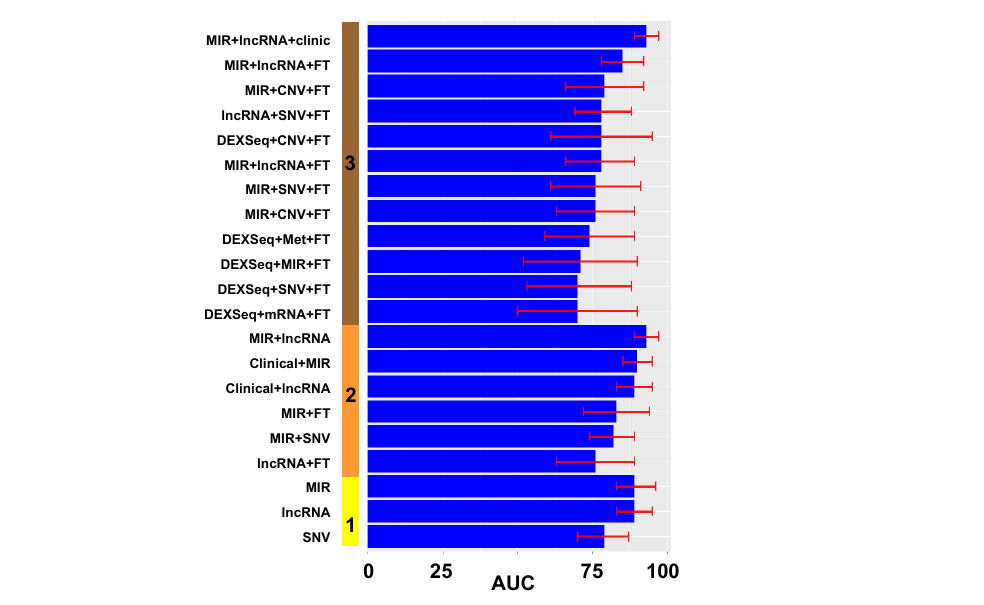
Figure 5. Performance of prediction models with selected variables from the best initial models in optimal cytoreduction. The solid vertical bar represents the number of types of data: 1 (yellow): only one variable was included in the model; 2 (orange): a combination of 2 types of variables; 3 types of variables: solid vertical line with 3 labels (maroon). Different performances are displayed in ascend ‐ ing order. The x axis is AUC as a percentage (0–100%). The red error mark displays the 95% confi ‐ dence interval (CI). We included all prediction models with a 95% CI of AUC that was included or was superior to 87%. Overall, 21 were selected (that had the potential to be superior to the clinical assessment). FT: fusion transcripts; Met: DNA methylation; SNV: single nucleotide variation; CNV: gene copy number; DEXSeq: exon expression; lncRNA: long non ‐ coding RNA; MIR: micro ‐ RNA, mRNA: gene expression. Graphics were generated with R package ggplot . In the complete cytoreduction models, 37 had 95% CI’s that crossed the 87% thresh ‐ old (Figure 6). A total of 19 of the 37 (51%) best ‐ performing models contained DNA meth ‐ ylation (Met) data and 16 of 37 (43%) contained clinical data.